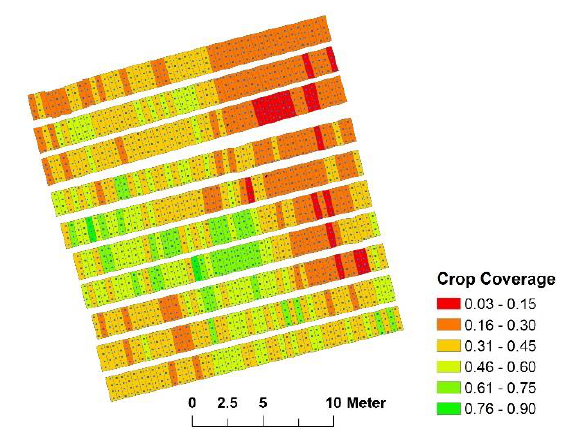
Figure 6: Proportion of crop coverage per parcel of the 2nd drone flight. The location of the individual plants (black dots) were computed in the 1 st